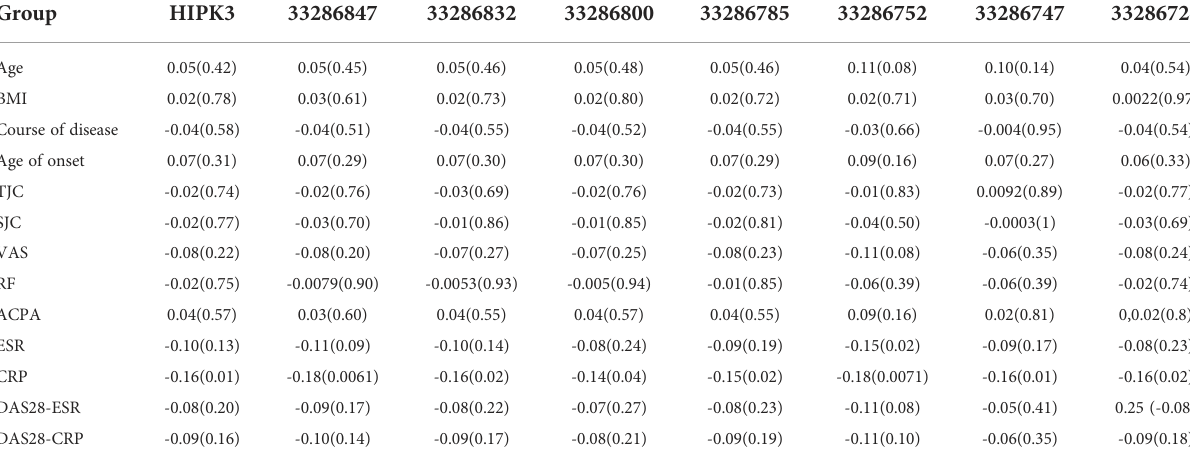
TABLE 1 Correlation analysis between the methylation level of different CpGs and clinical